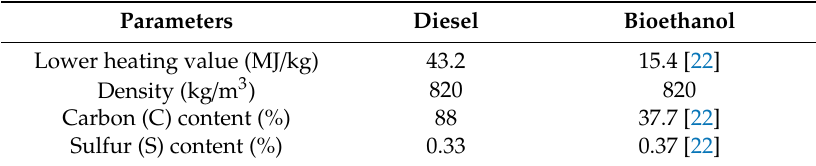
Table 6. Fuel properties of diesel and bioethanol.